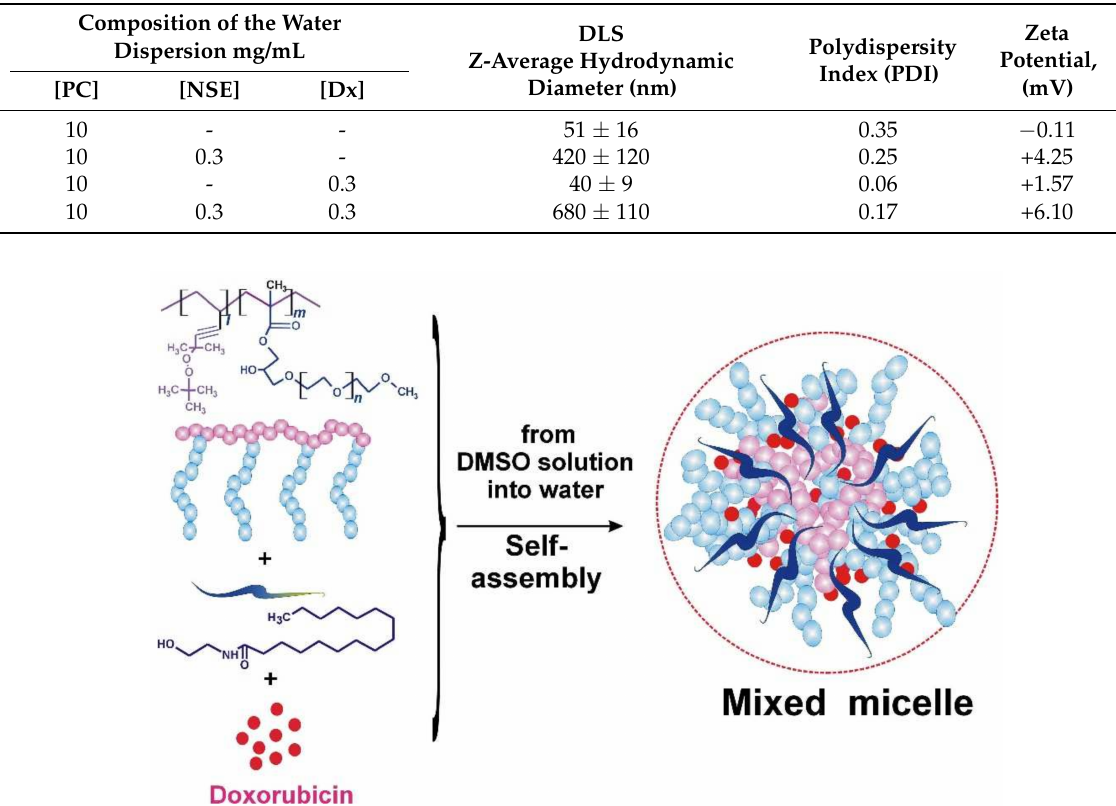
Figure 2. General scheme of the formation of a complex with Dx in mixed micelles with PC +